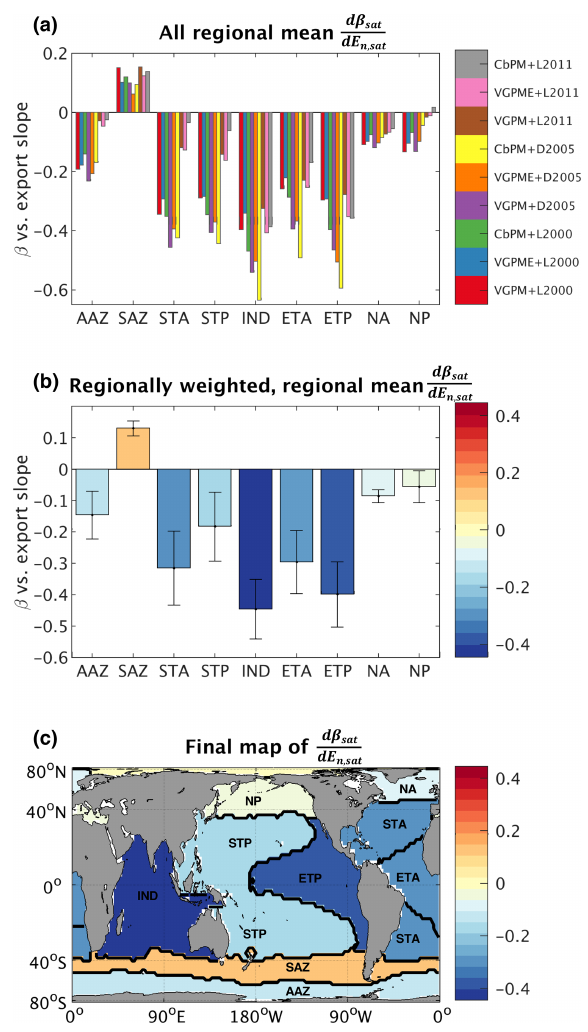
Figure 3. (a) All regional mean changes in particle size slope for a given change in time-mean normalized export, d β sat values d E n , sat (i.e., spatial averages of each map in Fig. S3 over regions shown in Fig. 2), colored by corresponding export map. Color bar la- bels indicate the NPP and e-ratio algorithms used to generate the given export map (see Sect. 2.2.2 for full descriptions of the algo- rithms). NPP algorithm key: VGPM represents the Vertically Gen- eralized Production Model (VGPM) (Behrenfeld and Falkowski, 1997); VGPME represents the Eppley-VGPM model (Carr et al., 2006); and CbPM represents the Carbon-based Production Model (Behrenfeld et al., 2005). E-ratio algorithm key: L2000 represents Laws et al. (2000); D2005 represents Dunne et al. (2005); and L2011 represents Laws et al. (2011). (b) Regionally weighted mean d β sat , averaged over the nine possibilities for each region shown d E n , sat in Fig. 3a. Error bars represent 1 weighted SD. (c) Global map of re- gionally variable d β sat used in model runs with the PSR feedback d E n , sat